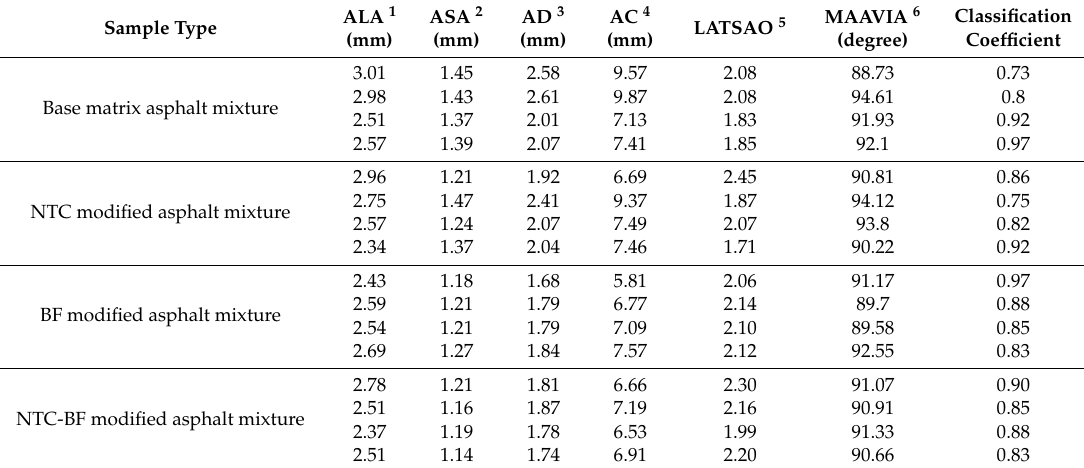
Table 7. The pore morphology of the test asphalt mixture under F–T